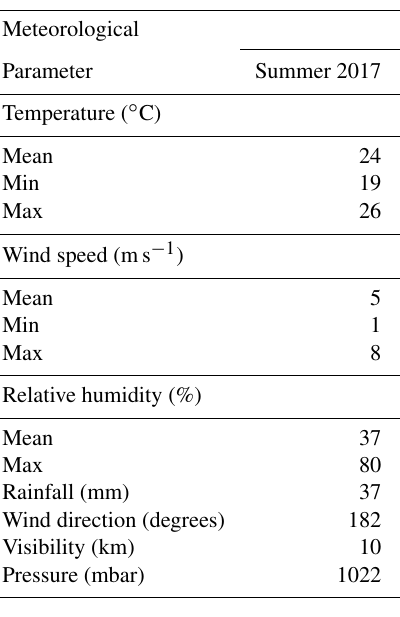
Table 1. Meteorological parameters over the Middle Atlas from summer 2017 to spring